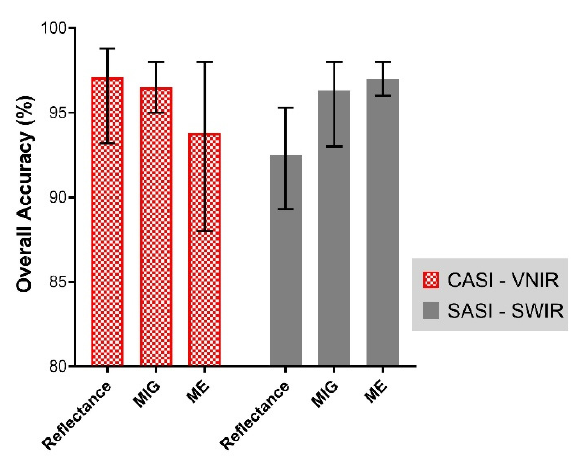
Figure 10. The mean classification accuracy for mangrove and forest achieved for each of the input datasets assessed in this study (i.e., Reflectance, MIG, and ME) for both VNIR and SWIR imagery. The error bars illustrate the minimum and maximum overall classification accuracy achieved for each dataset.